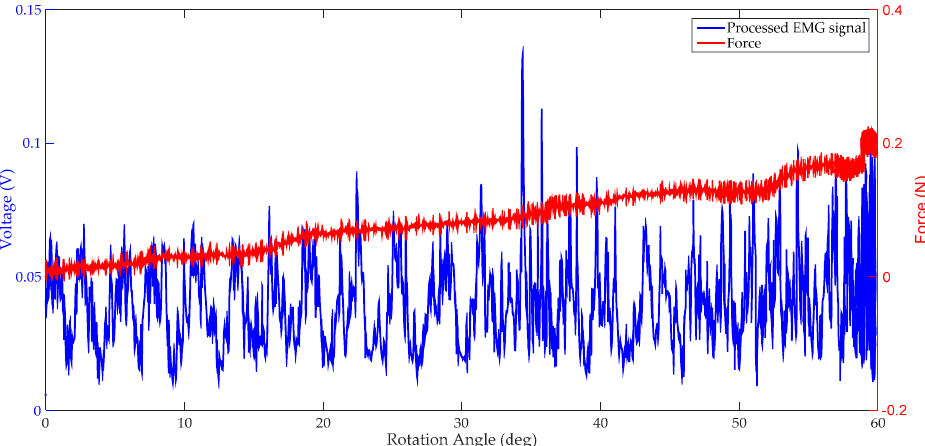
Figure 6. sEMG signal and interaction force during forearm flexion for case one (the motor did not provide the power to the robot frame).